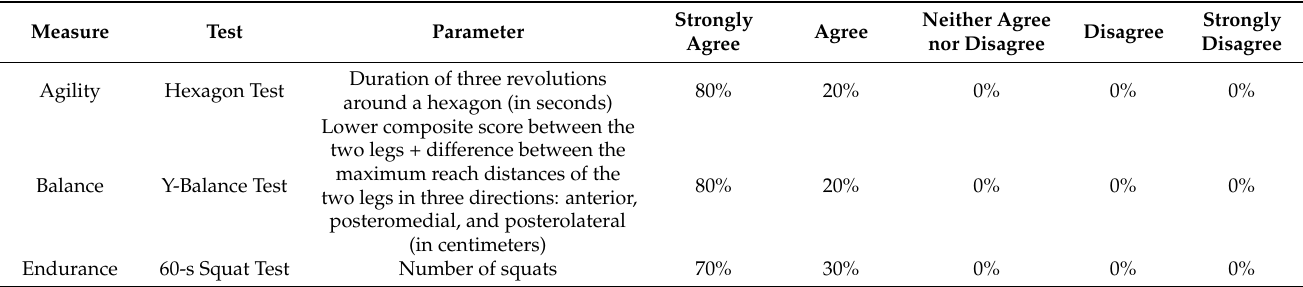
Table 2. Expert questionnaire for fitness tests ( n =